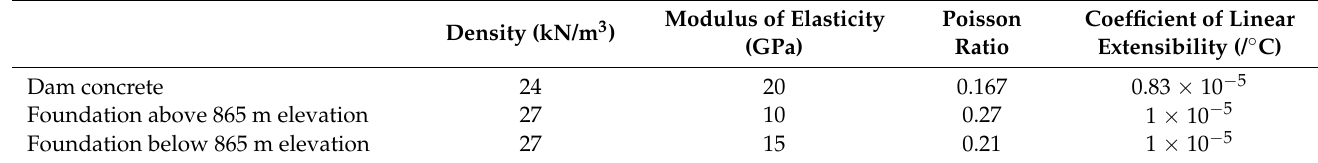
Table 2. Material properties of the dam and foundation.